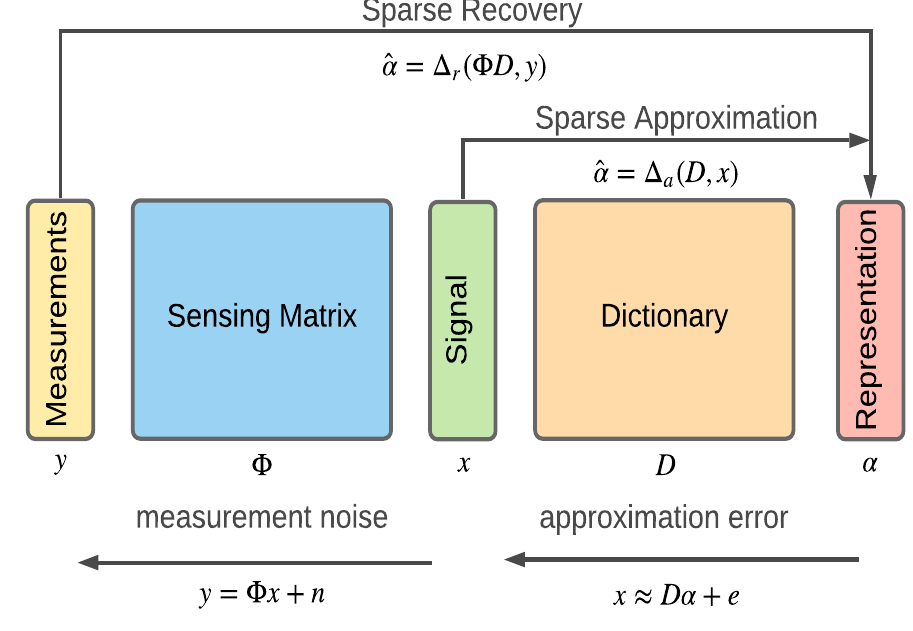
Figure 2. Framework of compressed sensing